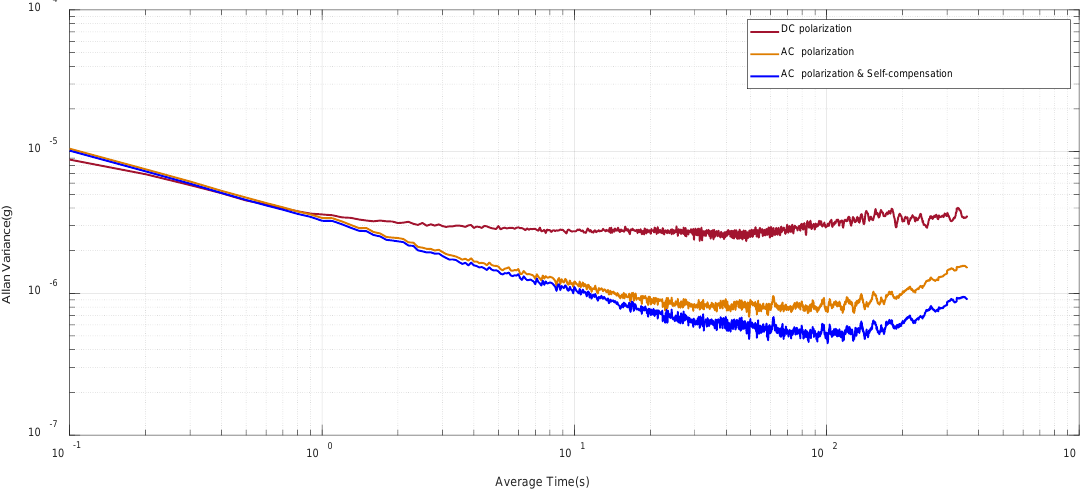
Figure 11. Allan variance test result under three polarization conditions, DC polarization, AC polarization and AC polarization with self-compensation.